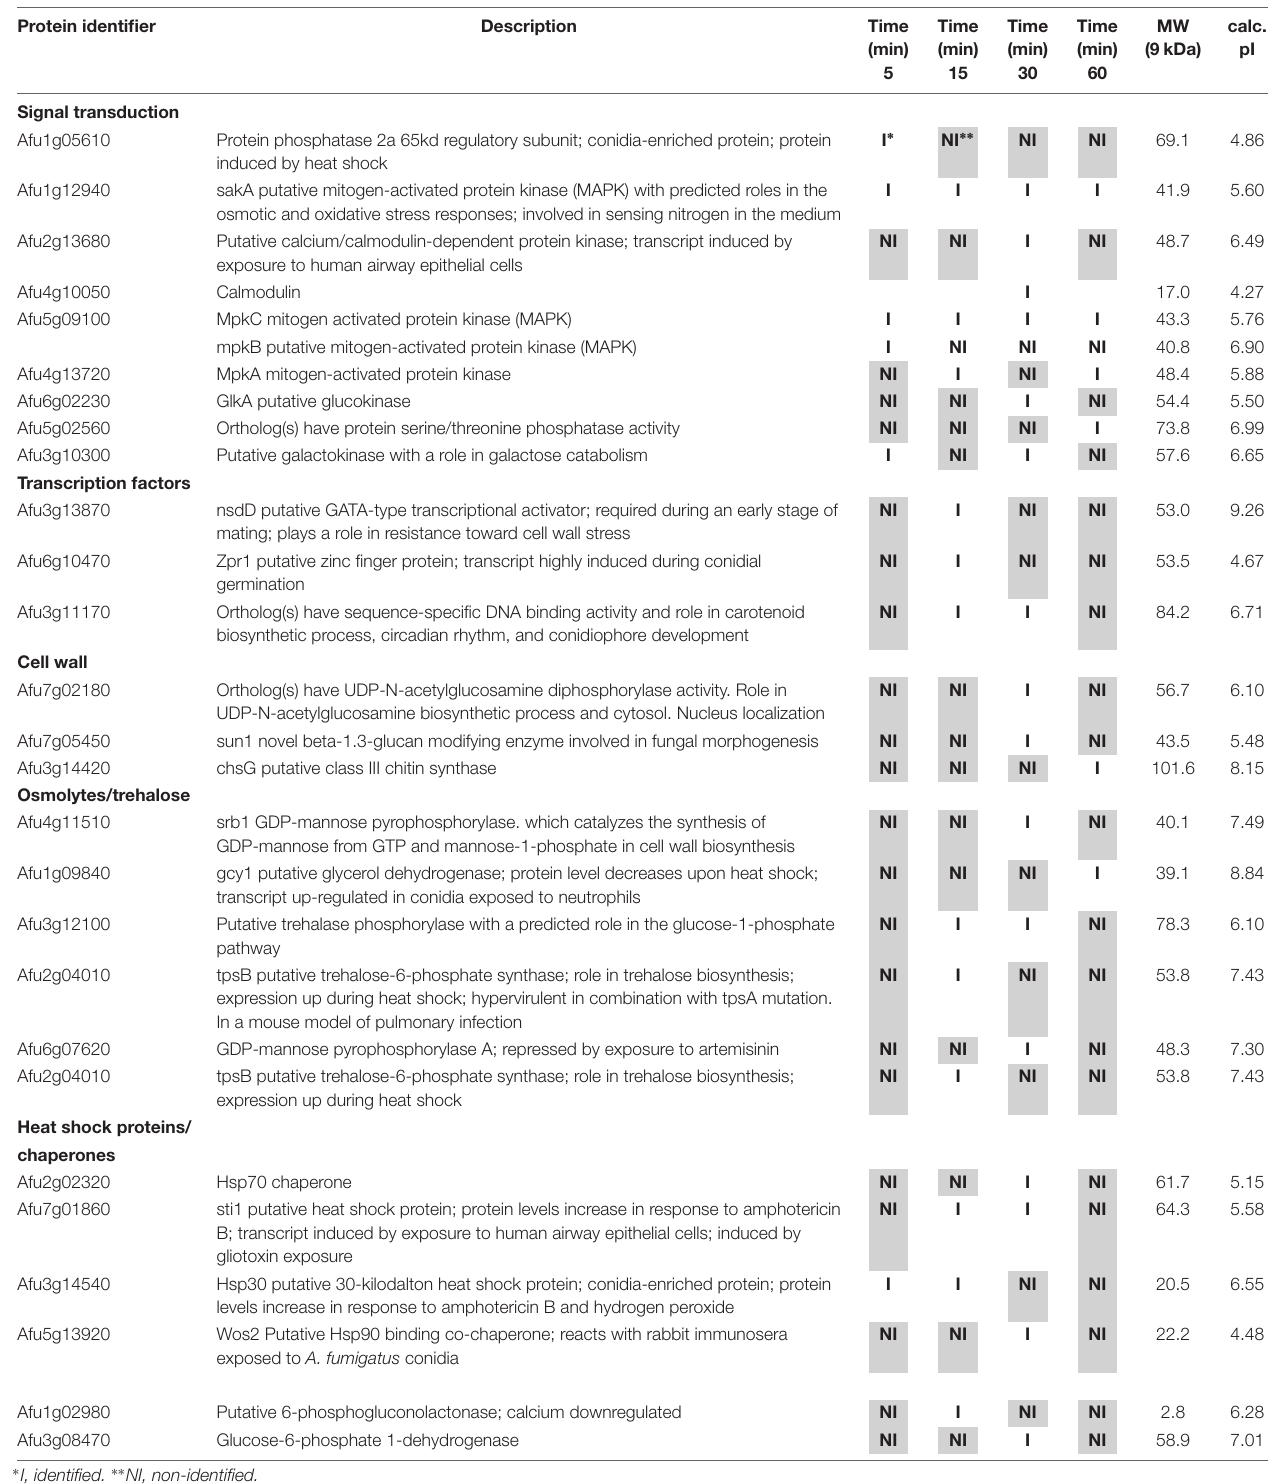
TABLE 4 | Selected proteins interacting with MpkC::GFP identified during cell wall stress. Protein identifier